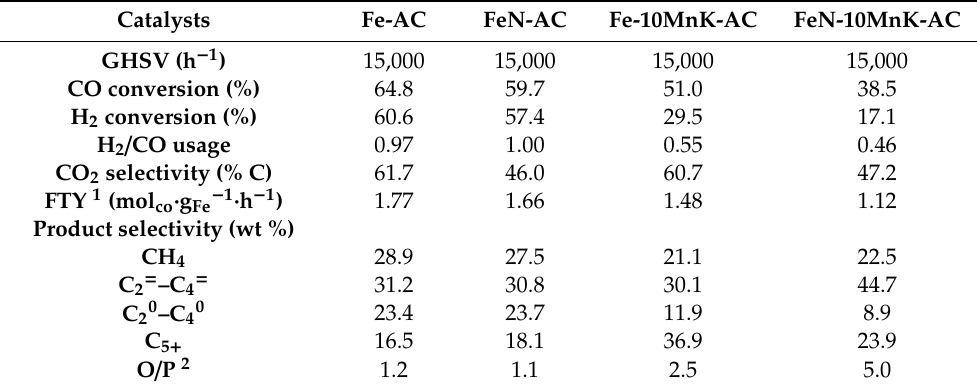
Figure 3. ( a ) TEM and ( b ) high resolution TEM (HRTEM) images of FeN-10MnK-AC catalysts. ( c ) High-angle annular dark field scanning transmission electron microscopy (HAADF-STEM) image and corresponding elemental mapping of FeN-10MnK-AC catalysts: ( d ) C; ( e ) Fe; ( f ) Mn; ( g ) K; ( h ) N. Table 2. FTO performances of iron catalysts and N-doped iron